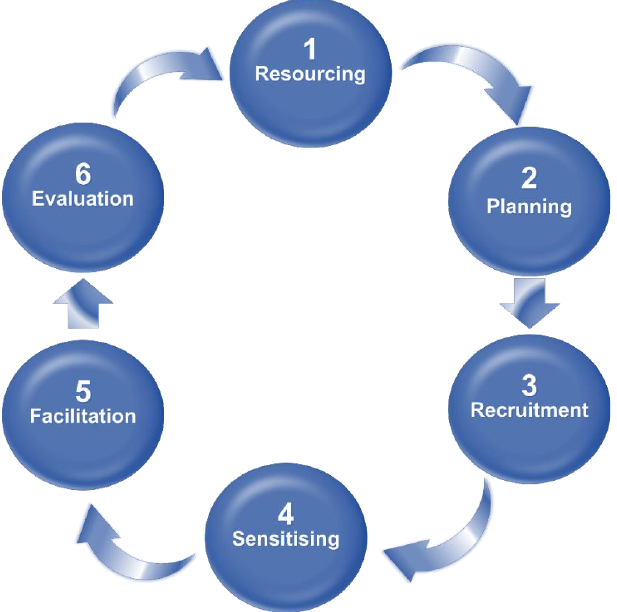
Figure 1. Six-step process of codesign Dietrich, Trischler, Schuster, and Rundle-Thiele [10].